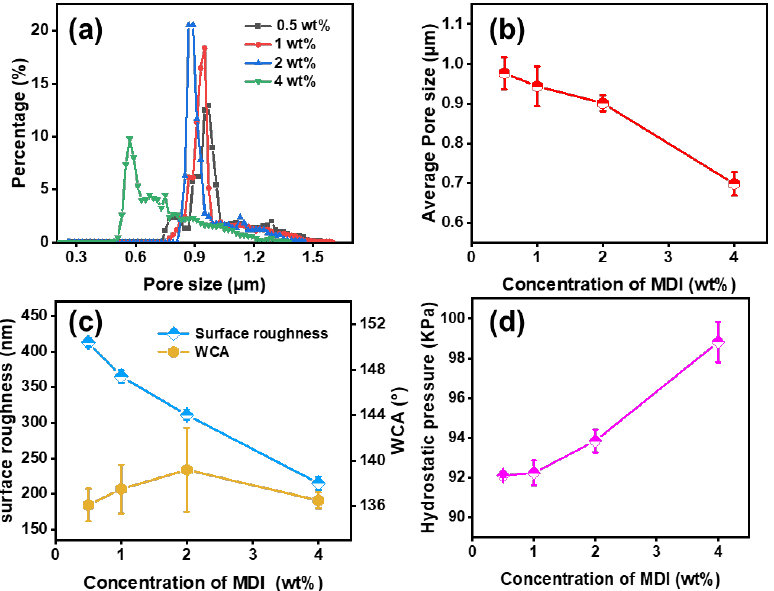
Figure 8. Pore structure, surface wettability and waterproof properties of PAN@AMP-1/MDI mem- branes modified by in-situ cross-linking of MDI with different concentrations: ( a ) pore size distribu- tion, ( b ) average pore size, ( c ) Ra values and contact angle, ( d ) hydrostatic pressure.